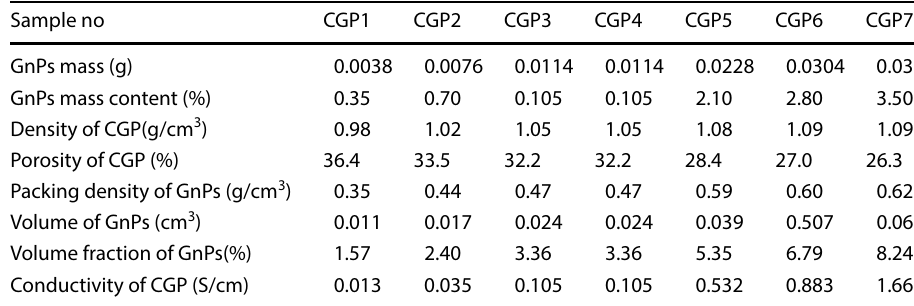
Table 1 Parameters and electrical resistance of CGP with different graphene